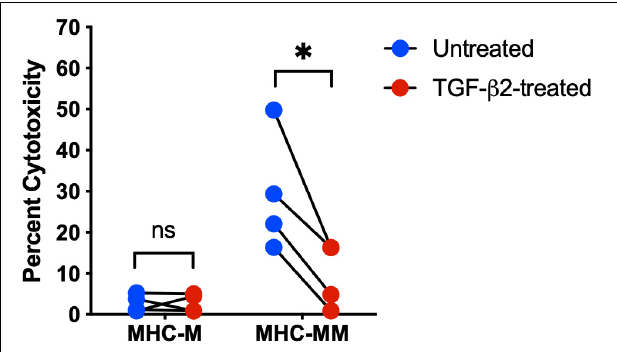
FIGURE 4 | TGF- β 2 treatment decreases the cytotoxicity of MHC-mismatched MSCs. Percent cytotoxicity in a standard 6-h chromium-51 release assay for MHC-matched and MHC-mismatched untreated and TGF- β 2-treated MSCs. MSC donor-paired samples are represented by connected lines for n = 4, * p = 0.0119 by a one-sample t -test on each pair.